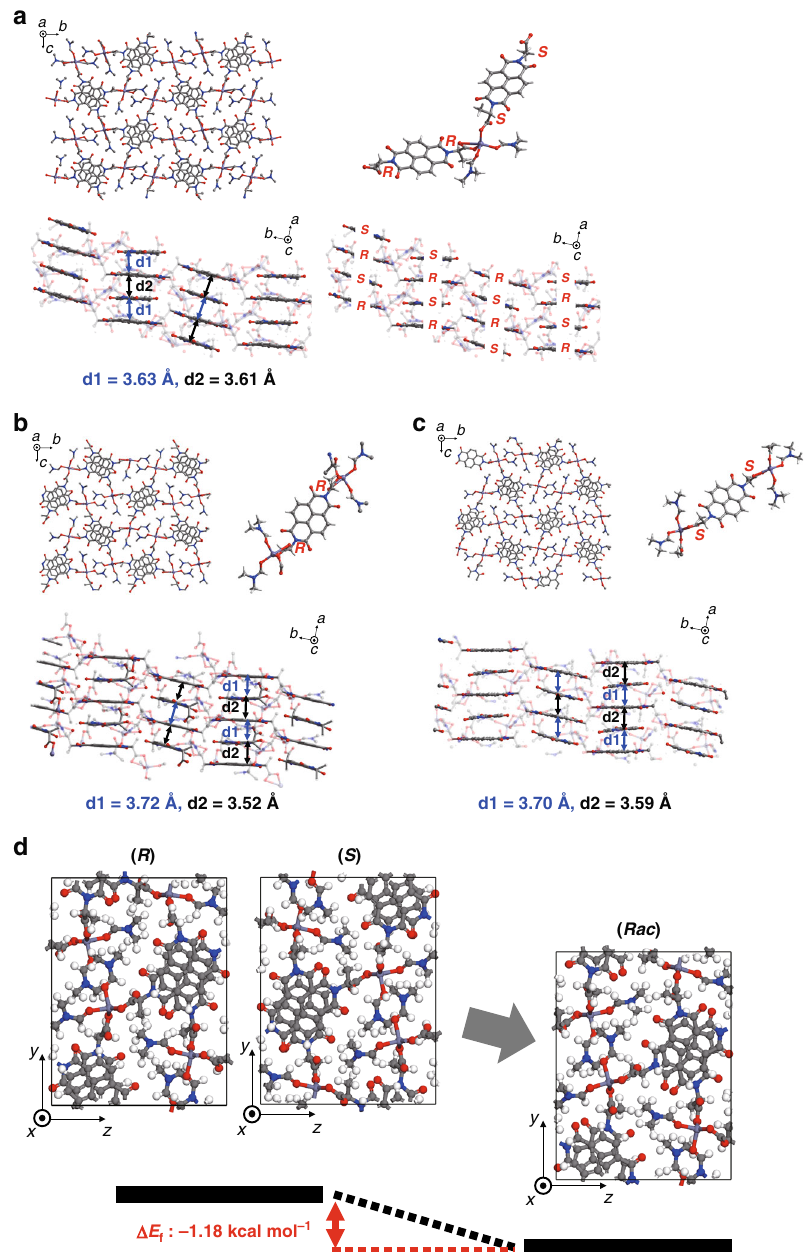
Fig. 1 Crystal structures of homochiral and heterochiral AlaNDI-Zn SBCPs and their chiral self-discrimination phenomena. a – c Crystal structures of a heterochiral ( Rac )-AlaNDI-Zn SBCP (top-left shows the a -axis projection, top-right shows a unit description containing two AlaNDI units in a 1D chain with the chirality description, bottom-left shows a π – π stacking scheme with centroid – centroid distances, and the bottom-right shows the chiral con fi guration in this SBCP), b homochiral ( R )-AlaNDI-Zn SBCP (top-left shows the a -axis projection, top-right shows a unit description containing one AlaNDI unit in a 1D chain with the chirality description, and bottom shows a π – π stacking scheme with centroid – centroid distances), and c ( S )-AlaNDI-Zn SBCP (top-left shows the a -axis projection, top-right shows a unit description containing one AlaNDI unit in a 1D chain with the chirality description, and bottom shows a π – π stacking scheme with centroid – centroid distances). Atom coloring: Zn, thin-purple, C, gray, N, blue, O, red, and H, white. Except for the top-right fi gure in each, hydrogen atoms were omitted for clarity. d Formation energy ( Δ E f ) calculation results for chiral discrimination phenomena in heterochiral SBCPs. The carbon, hydrogen, oxygen, nitrogen, and zinc atoms of AlaNDI-Zn SBCPs are colored gray, white, red, blue, and thin-purple, in the anti-conformation with respect to the NDI core. All slightly tilted NDI planes. The centroid-to-centroid distances of AlaNDI ligands are connected with Zn(DMF) 2 units to form a 1D NDI planes are 3.58 and 3.72 Å for ( R )-AlaNDI-Zn, 3.59 and zigzag-chain SBCP. NDIs have strong π -planar stacking ability in 3.70 Å for ( S )-AlaNDI-Zn, and 3.61 and 3.63 Å for ( Rac )- the solid state due to their planar aromatic nature 32 . Thus, the AlaNDI-Zn, respectively. The order of stability in the interaction zigzag chains are cross-linked to form a 3D framework through of two π systems is π -de fi cient··· π -de fi cient > π -de fi cient··· π -rich > π -rich··· π -rich 33 . Therefore, this π -de fi cient functionality of NDI strong intermolecular π – π interactions. Each BCP has two groups can be used to implement strong, directional π – π stacking centroid-to-centroid distances of NDI planes because of the